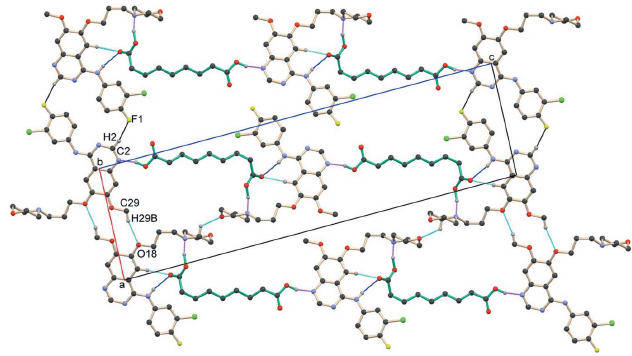
Figure 4 The ‘molecular clip’-like geometry of GTB that accommodates a carboxyl group of AA. The molecules interact through N—H (cid:2)(cid:2)(cid:2) O, O—H (cid:2)(cid:2)(cid:2) N and C—H (cid:2)(cid:2)(cid:2) O hydrogen bonds.